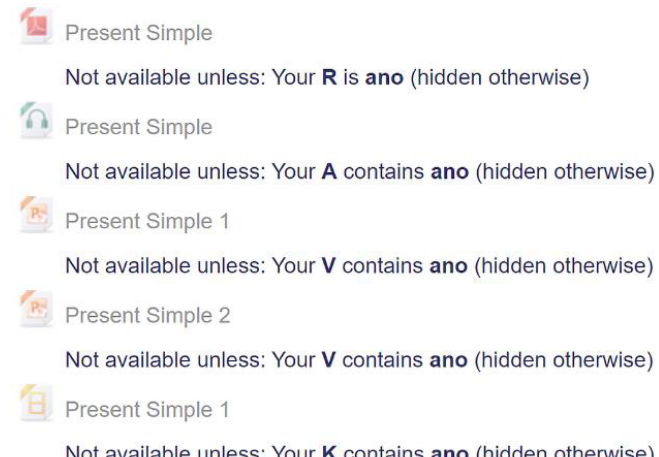
Figure 7. Illustration of conditional access to study materials according to VARK.